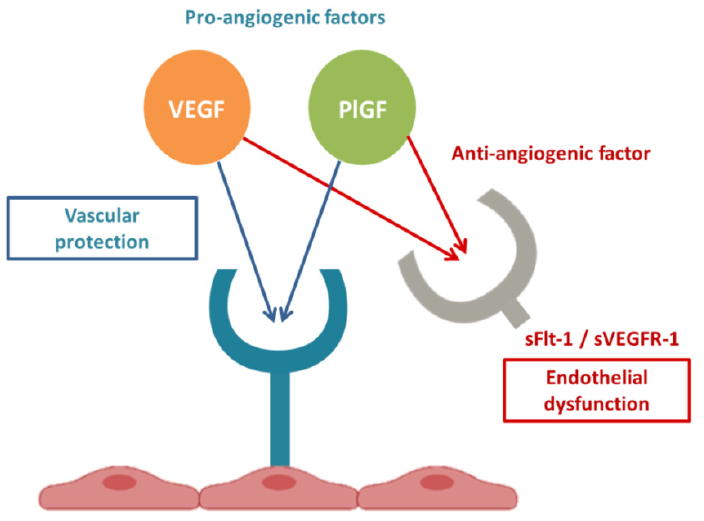
Figure 3. Angiogenic factor interactions. Preeclamptic women show an imbalance between sFlt-1, VEGF, and PlGF in serum. sFlt1 levels are increased, and placental sFlt1 mRNA is upregulated, whereas free (unbound) PlGF and free VEGF levels are suppressed [32]. Changes in these markers precede the onset of clinical disease. It has been suggested that sFlt-1 could provoke generalized endotheliosis in blood vessels, leading to hypertension and proteinuria [29]. A causal relationship between sFlt1 and the clinical manifestations of PE was suggested in a study by Levine et al., which showed that an increase in circulating levels of sFlt1 was correlated with greater severity of PE [33]. Currently, the sFlt1/PlGF ratio is used as a clinical biomarker for the early detection and prognosis of PE [34]. An angiogenic imbalance also seems to be present in COVID-19, as shown by our group [8]. Levels of sFlt-1 were also noted to be significantly higher in patients with pneumonia due to COVID-19, compared to those with pneumonia due to other causes and to healthy controls. PlGF values were not significantly affected by COVID-19, but the sFlt1/PlGF ratio was higher in COVID- 19-positive pneumonia compared with COVID-19-negative pneumonia (14.1 vs. 5.0). identified sFlt-1 as a biomarker to predict survival and thrombotic accidents in COVID-19 including sepsis and acute pancreatitis, which are conditions with elevated sFlt-1